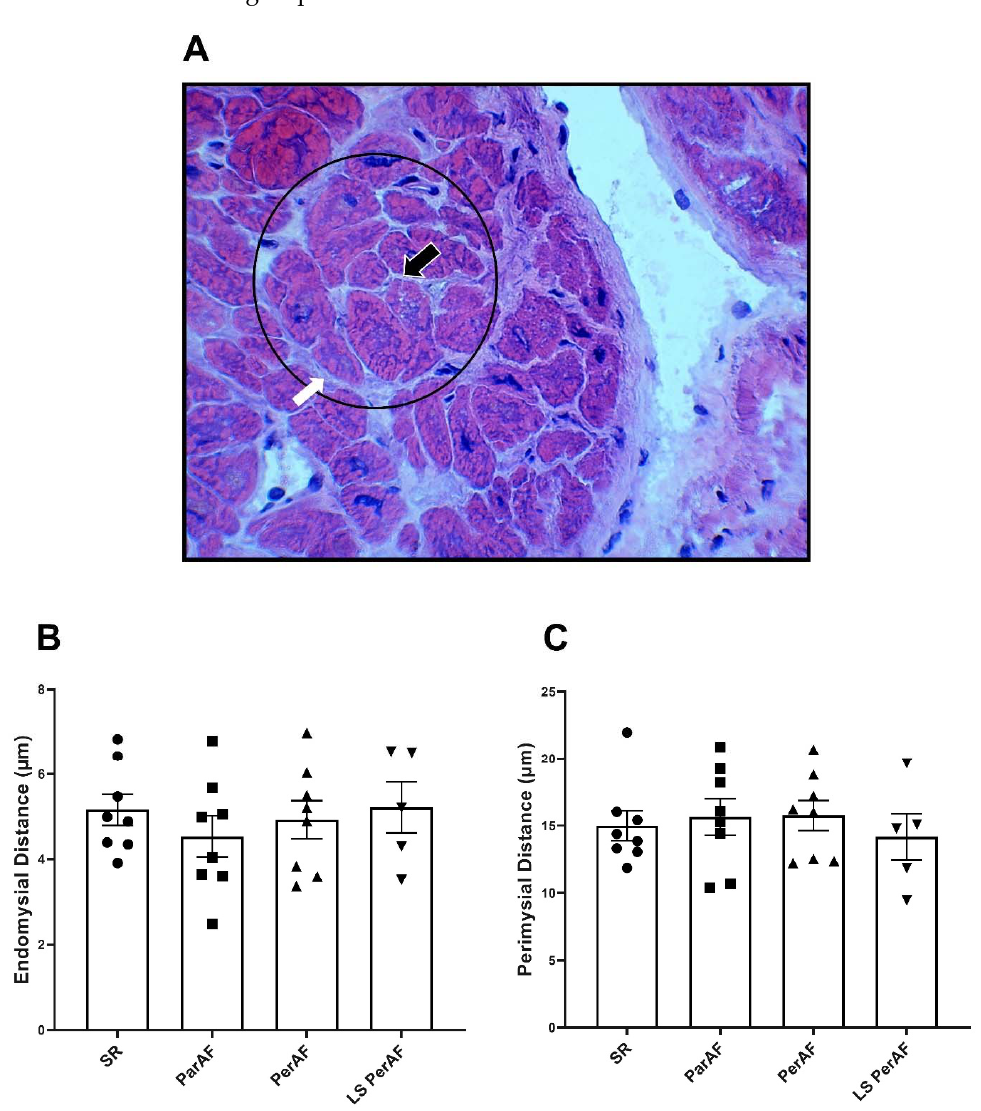
Figure 1. H&E staining reveals no increase in endo-perimysial fibrosis. In ( A ); representative example of cardiac bundle and perimysial space in human atrial tissue. Circle presents a cardiac bundle, white arrow shows perimysial space, and black arrow shows endomysial space. No significant dif- ference between stages of AF and control SR group in terms of endomysial fibrosis (N = 8, SR; N = 8, ParAF; N = 8, PerAF; N = 5, LS PerAF) ( B ), and perimysial fibrosis (N = 8, SR; N = 8, ParAF; N = 8, PerAF; N = 5, LS PerAF) ( C ); respectively, p = 0.77 and p = 0.7542. SR = control group, ParAF = par- oxysmal atrial fibrillation, PerAF = persistent atrial fibrillation, LSPerAF = longstanding persistent atrial fibrillation. Statistical tests used: ANOVA.